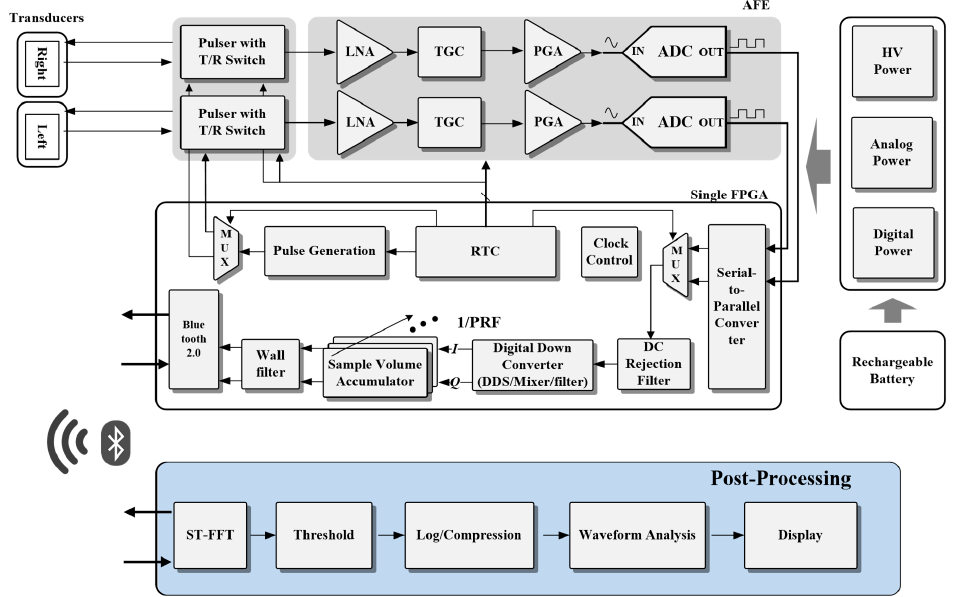
Figure 2. Overall system design of the wireless carotid wearable ultrasound Doppler device; LNA: Low-noise amplifier; TGC: Time-gain compensator; PGA: Programmable gain amplifier; ADC: Analog-to-digital converter; RTC: Real-time controller; MUX: